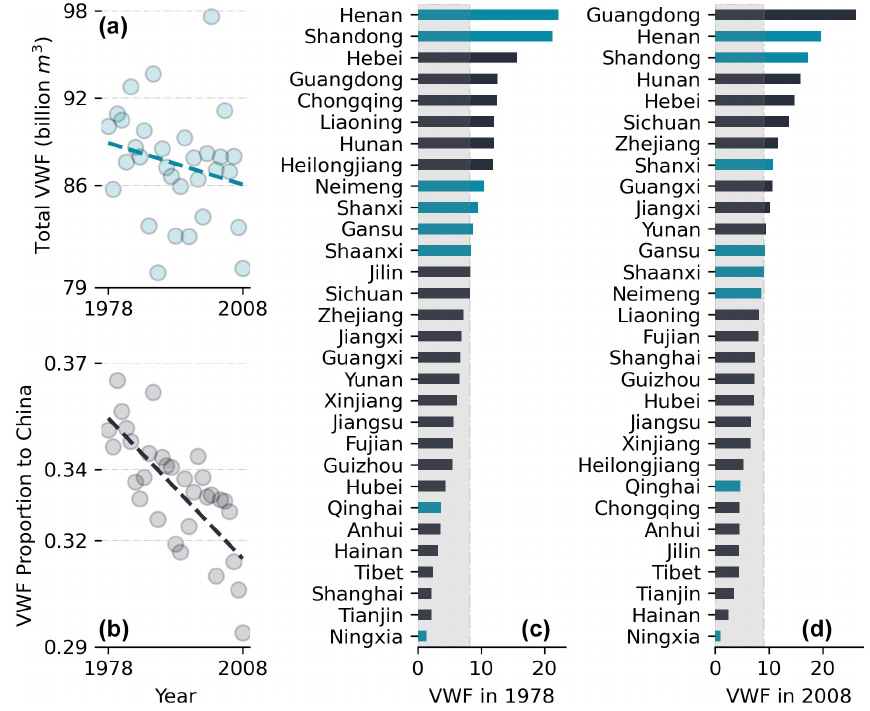
Figure 2. Virtual water outflows (VWFs) of the Yellow River basin (YRB) changes from 1978 to 2008. (a) Total VWF in the YRB and China. (b) Proportion of total VWF in the YRB to the national volume. (c) Ranking of VWF in Chinese provinces in 1978. Blue bars are provinces in the YRB. (d) Ranking of VWF in Chinese provinces in 2008. Blue bars are provinces in the YRB.